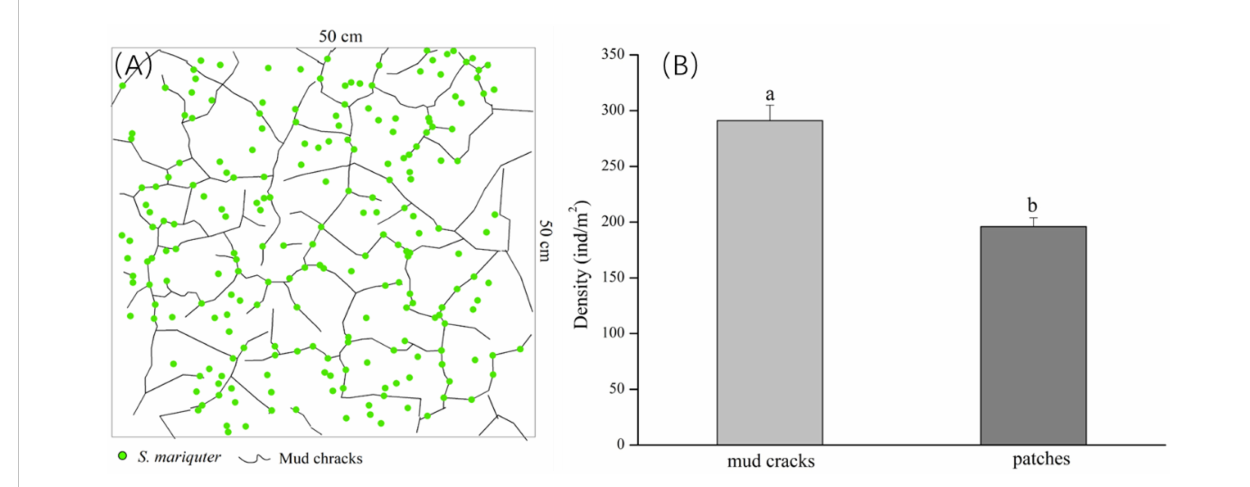
FIGURE 4 Distribution of S. mariqueter in mud cracks and patches in the study site. (A) An illustration of the distribution patterns of individual plants, and mud cracks: green dots are plants and black lines are mud cracks. (B) Bar graphs showing plant densities in the mud cracks and